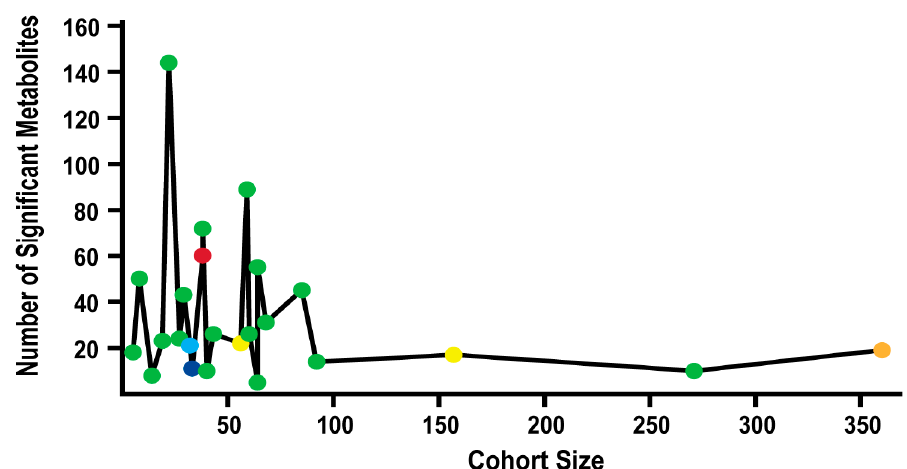
Figure 4. Significant Metabolites, Cohort Size, and p -value. Line chart comparing cohort size and the number of metabolites identified as significantly changing. Circle colors correspond to p -value used in the study to identify statistical significance: p < 1 × 10 − 5 (dark blue), p < 0.001 (light blue), p < 0.01 (red), p ≤ 0.05 (green), p < 0.1 (orange), and p < 0.3 (yellow). One study was excluded since it did